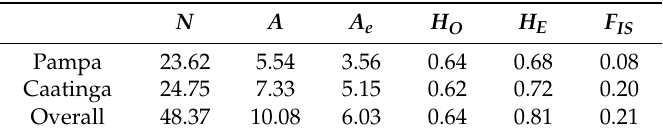
Table 2. Multilocus estimations of genetic diversity ( A , Ae , H O and H E ) and within population fixation index ( F IS ). The mean number of samples ( N ) is given. Values are the average across 24 SSR loci. N A A e H O H E F IS